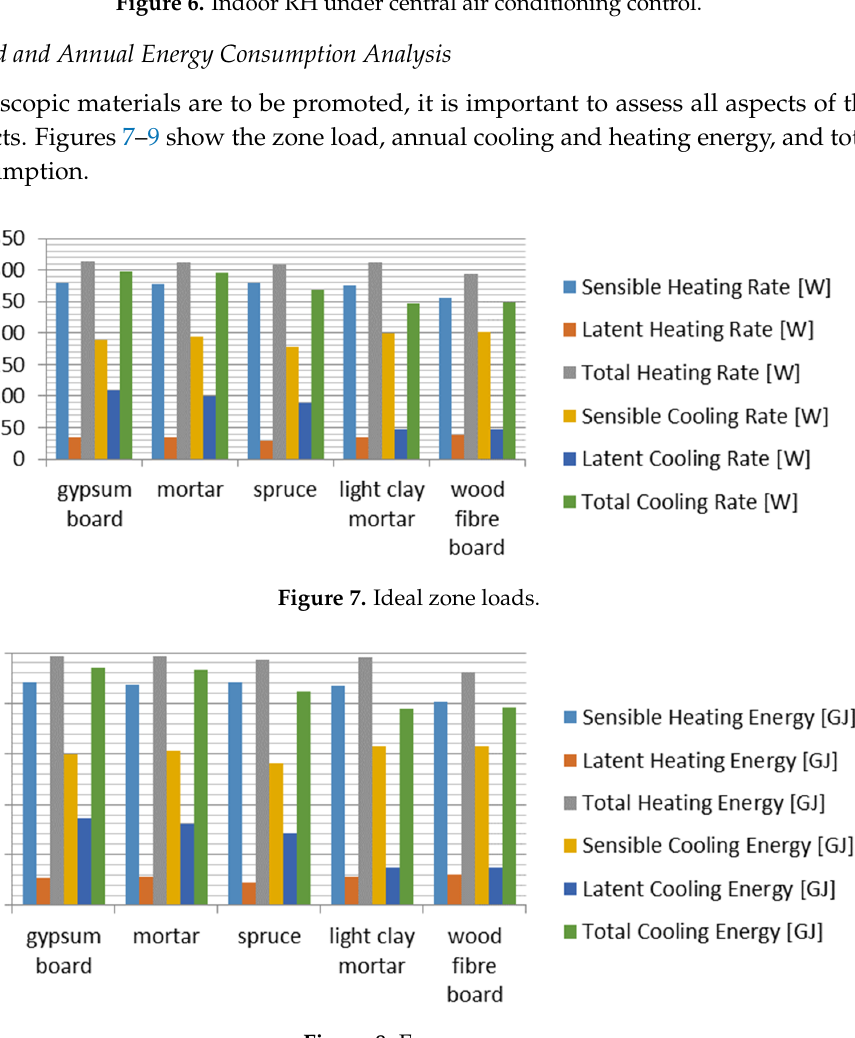
Figure 8. Energy use.